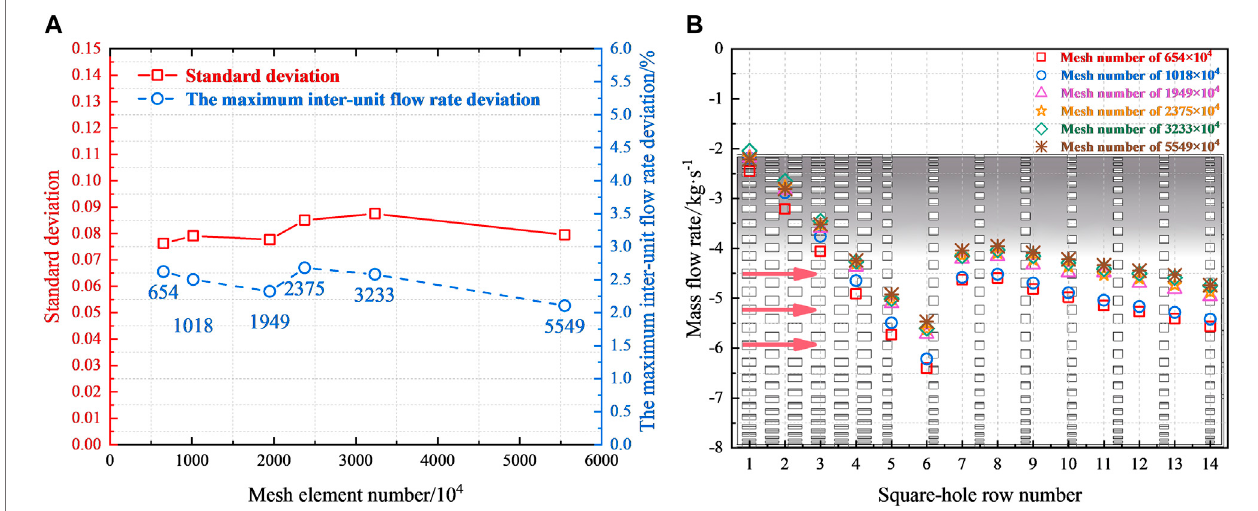
FIGURE 5 | Sensitivity analysis. (A) Variation with mesh element number. (B) Flow distribution characteristics.